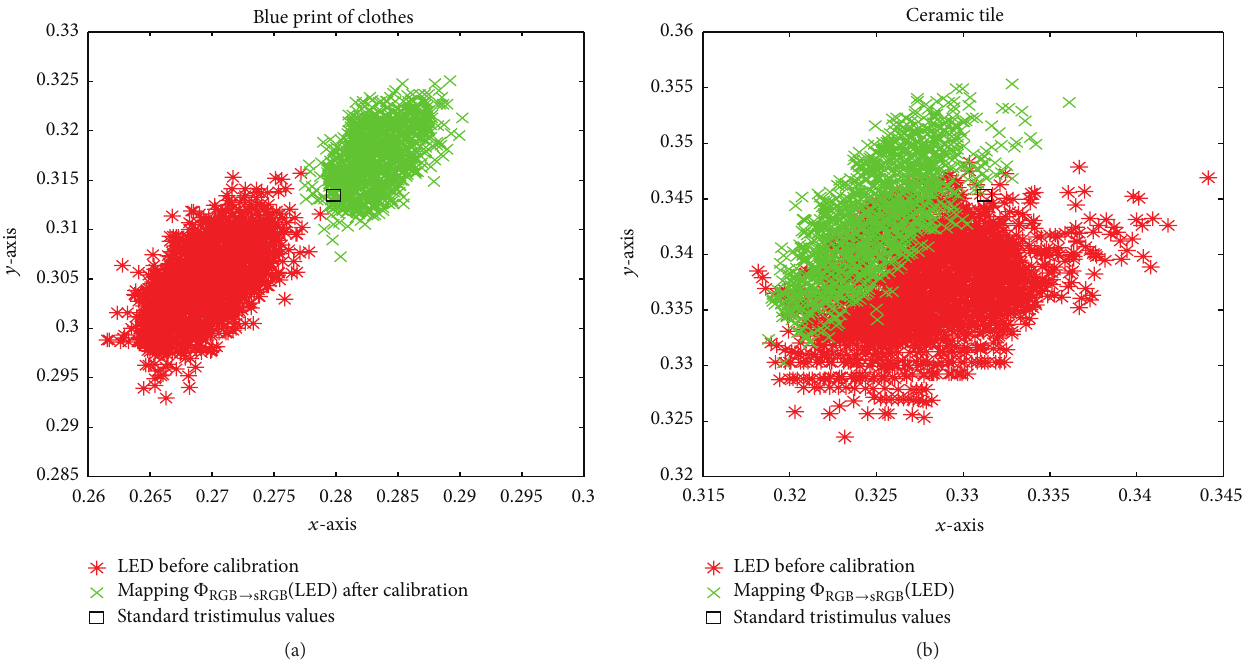
0.26 0.265 0.27 0.275 0.28 0.285 0.29 0.295